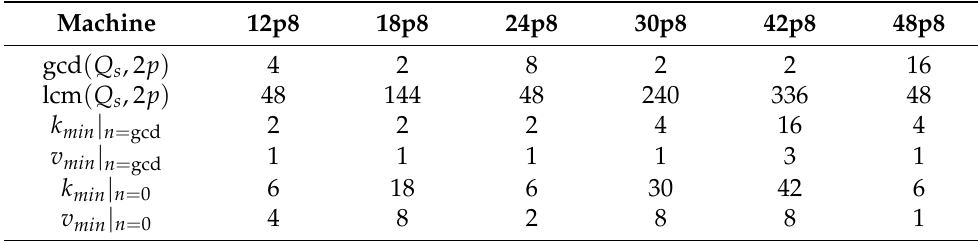
Table 6. Characteristics of the machines of 8 pole pairs.